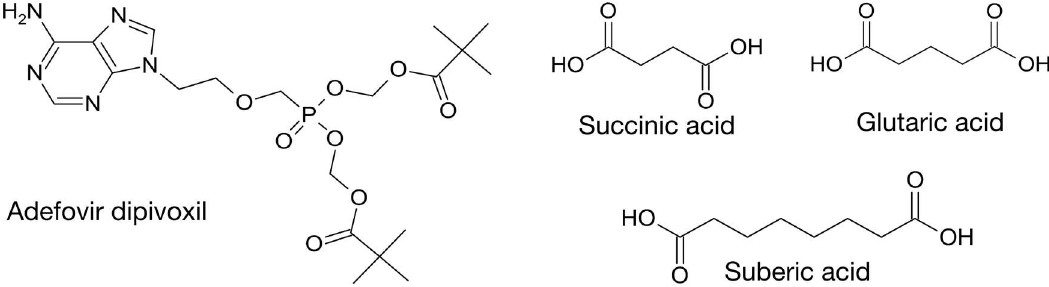
Figure 1. Chemical structures: adefovir dipivoxil (AD); succinic acid (SUC); glutaric acid (GLU); suberic acid (SUB).